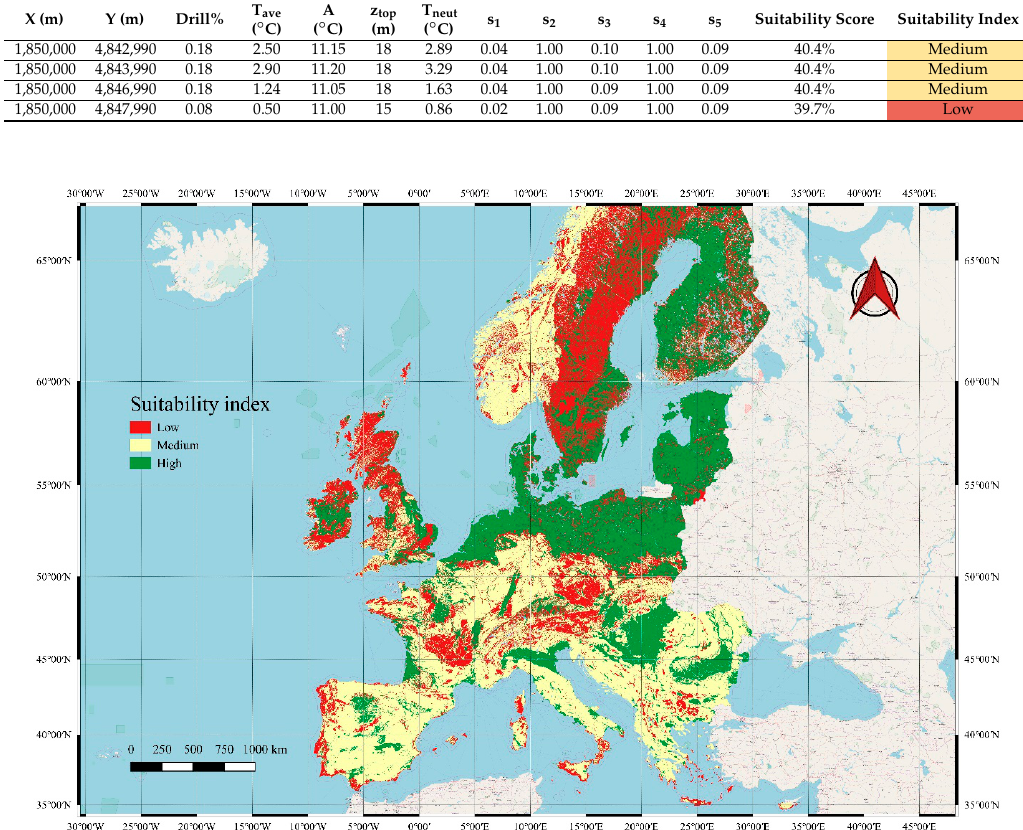
Figure 8. Qualitative suitability of GEOTeCH technology in Europe.